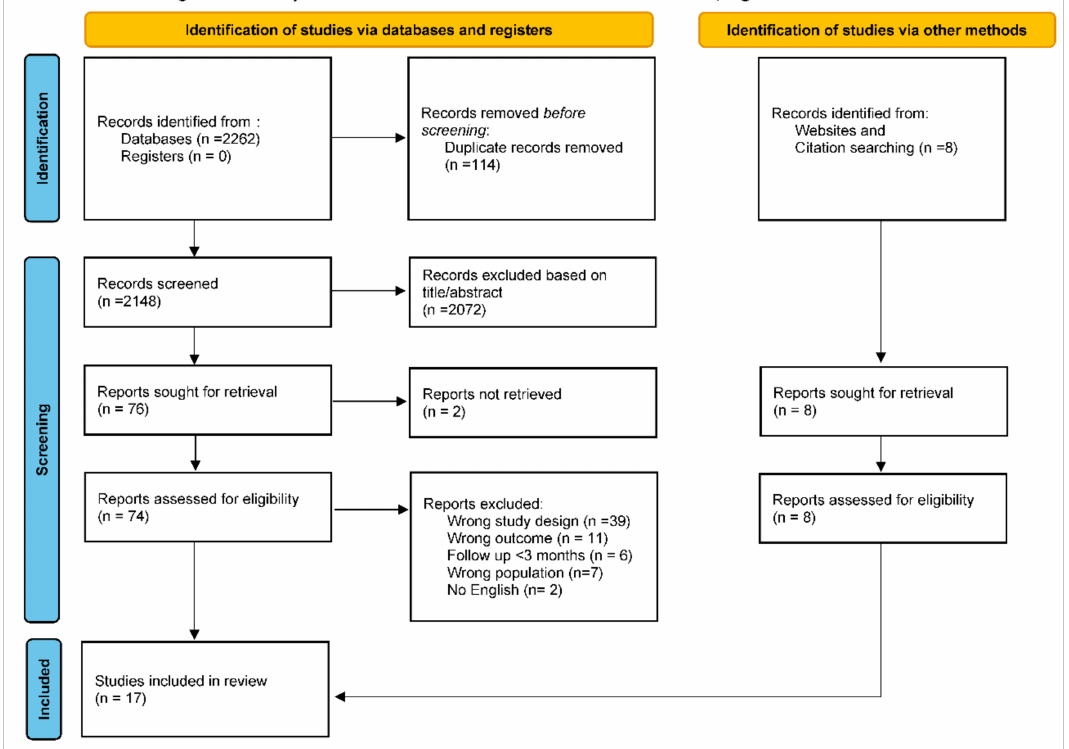
Figure 1. Diagram flow of studies screened and included in the review and